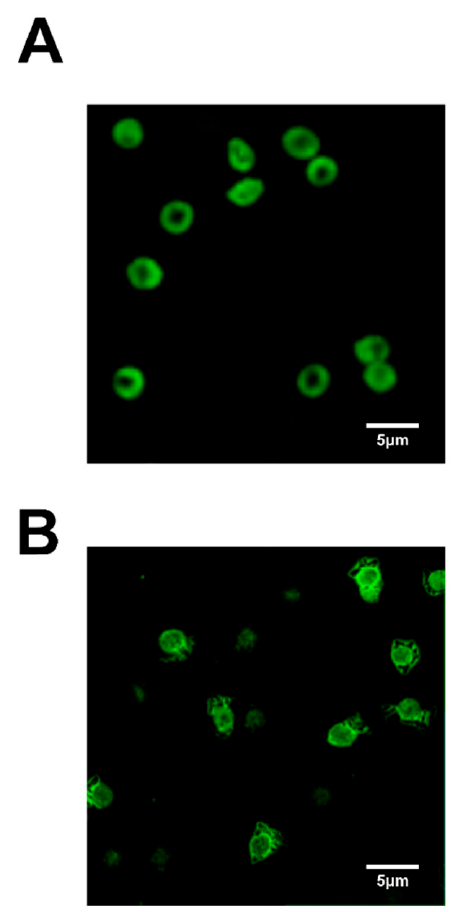
Figure 4. Morphological analysis of Hg-exposed RBC. Confocal Laser Scanning microscope imaging of intact RBC incubated in vitro in the presence of 20 µ M HgCl 2 . At the end of incubation, cells were stained with Annexin V-FITC. ( A ) Untreated RBC; ( B ) HgCl 2 -treated RBC. Unpublished photos.